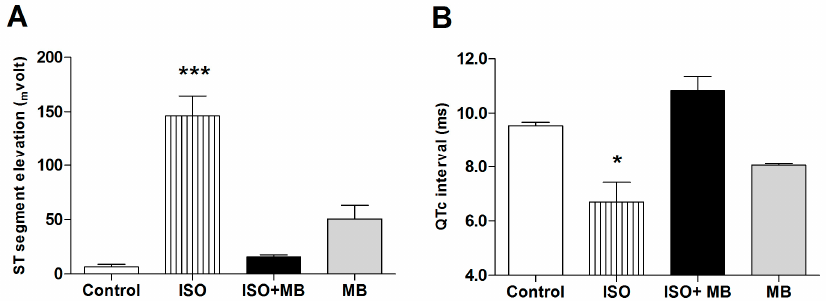
Figure 2. Treatment, with M. bijugatus , of a myocardial injury caused by ISO. The data shows the effects of MB and ISO on ST segment elevation ( A ) and the duration of the QTc interval of the ECG ( B ). ISO (85 mg/Kg) significantly elevated the ST segment ( p < 0.001) and shortened the QTc interval ( p < 0.05), which recovered after treatment with 100 mg/Kg of M. bijugatus . The extract did not, per se , cause any change. * p < 0.05, *** p < 0.001 vs. control; n = 5.